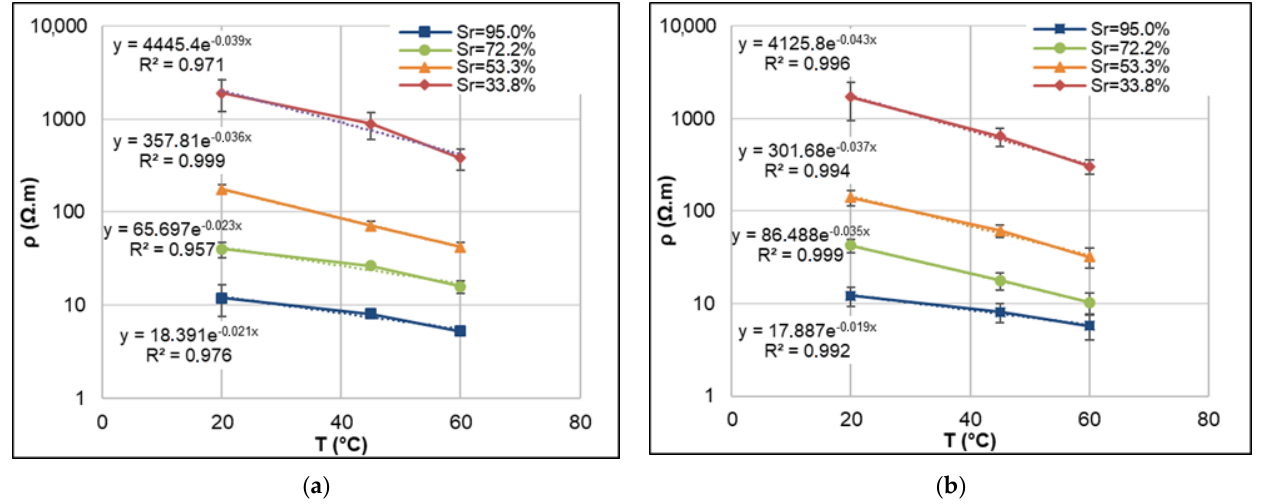
Figure 6. Variation of the average concrete resistivity as a function of temperature at different degrees of saturation: ( a ) transmission configuration; ( b ) Wenner configuration.